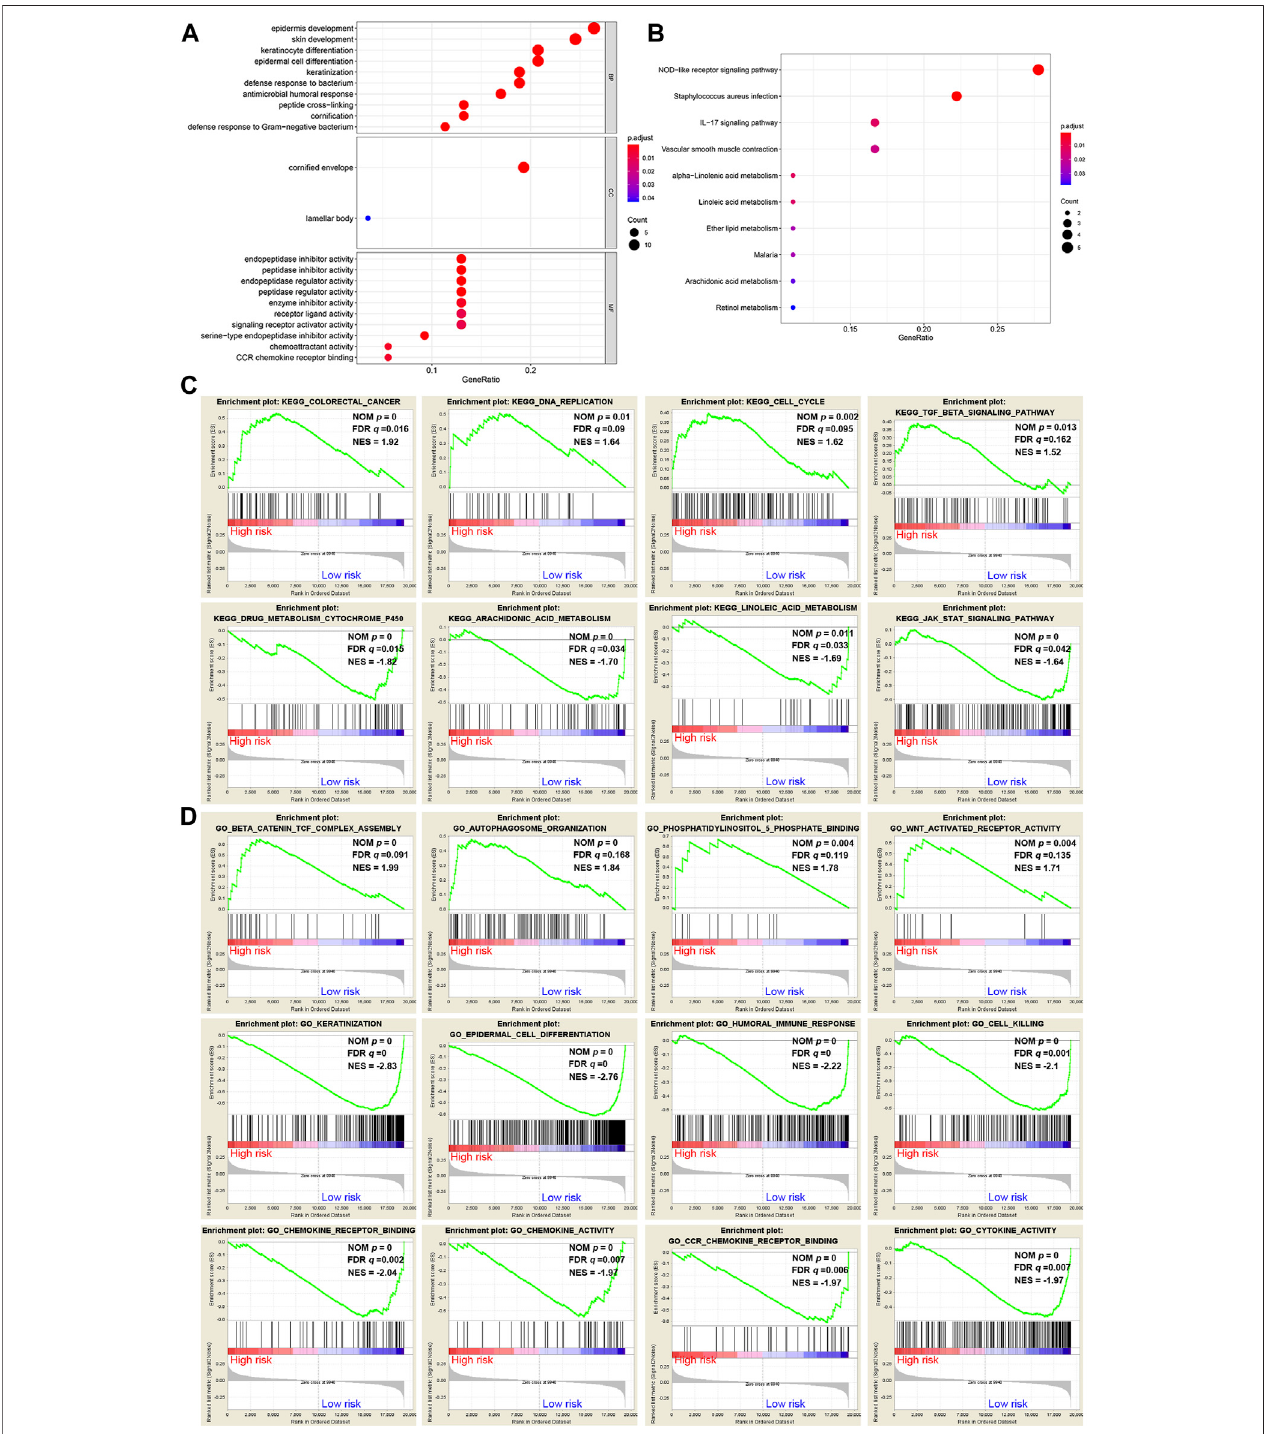
FIGURE 7 | Representative results of GO and KEGG analyses. (A,B) The most signi fi cantly enriched GO terms and KEGG pathways in the GSE53624 cohort are displayed. (C,D) GSEA between the low- and high-risk groups performed using KEGG and GO gene sets in the GSE53624 cohort.